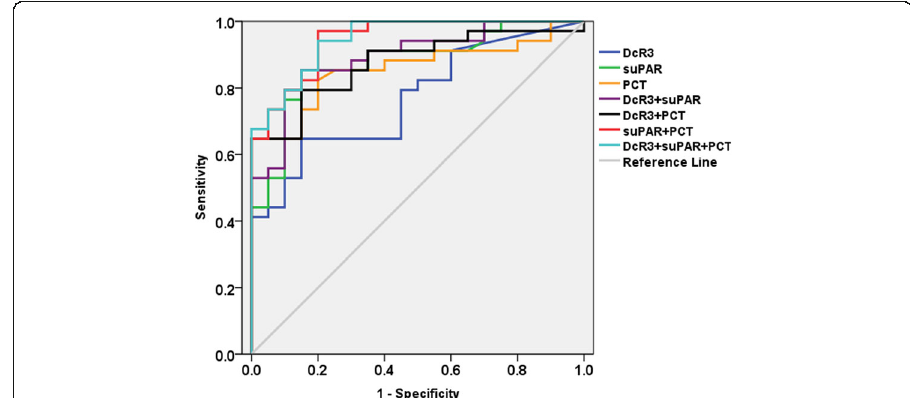
Fig. 3 ROC evaluation of DcR3, suPAR, PCT and DcR3 combined with suPAR, PCT in control group vs. SIRS group. The ROC evaluation was performed at cut-off values recommended by the scientific community of laboratory medicine with 95% CI